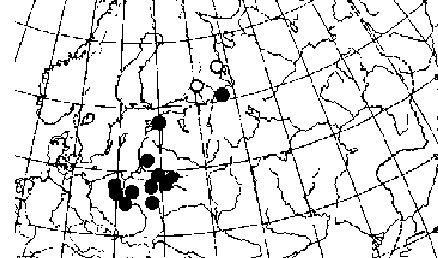
Fig. 5. Distribution of Verrucaria xyloxena in Eastern and East Central Europe (cid:2) records more than 50 year old, (cid:3) modern